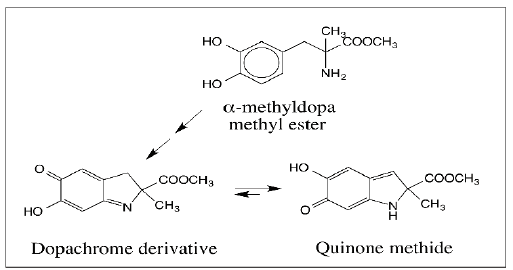
Figure 17. First demonstration of quinone methide production in a dopachrome derivative. α -Methyl dopa methyl ester upon oxidation produces its dopachrome derivative, which rapidly isomerizes to quinone methide under physiological conditions.